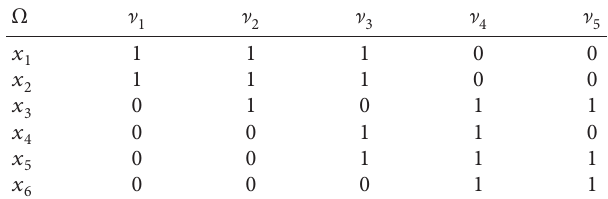
Table 1: Table for ( 􏽥 F ,tA )